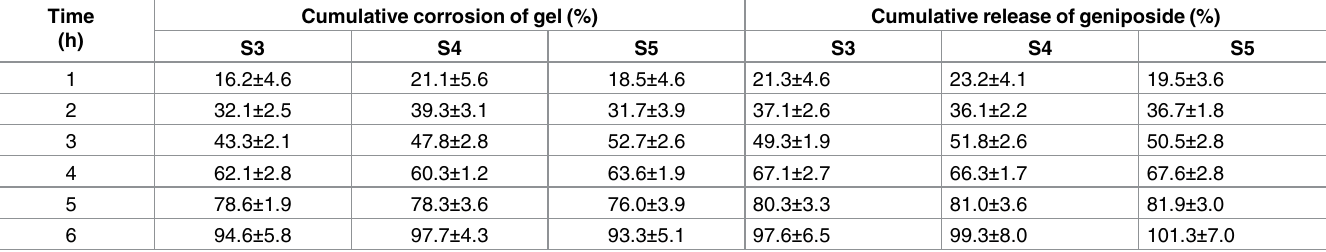
Table 8. Corrosion of gel and release of geniposide from the optimized formulations. Time Cumulative corrosion of gel (%) Cumulative release of geniposide (h)